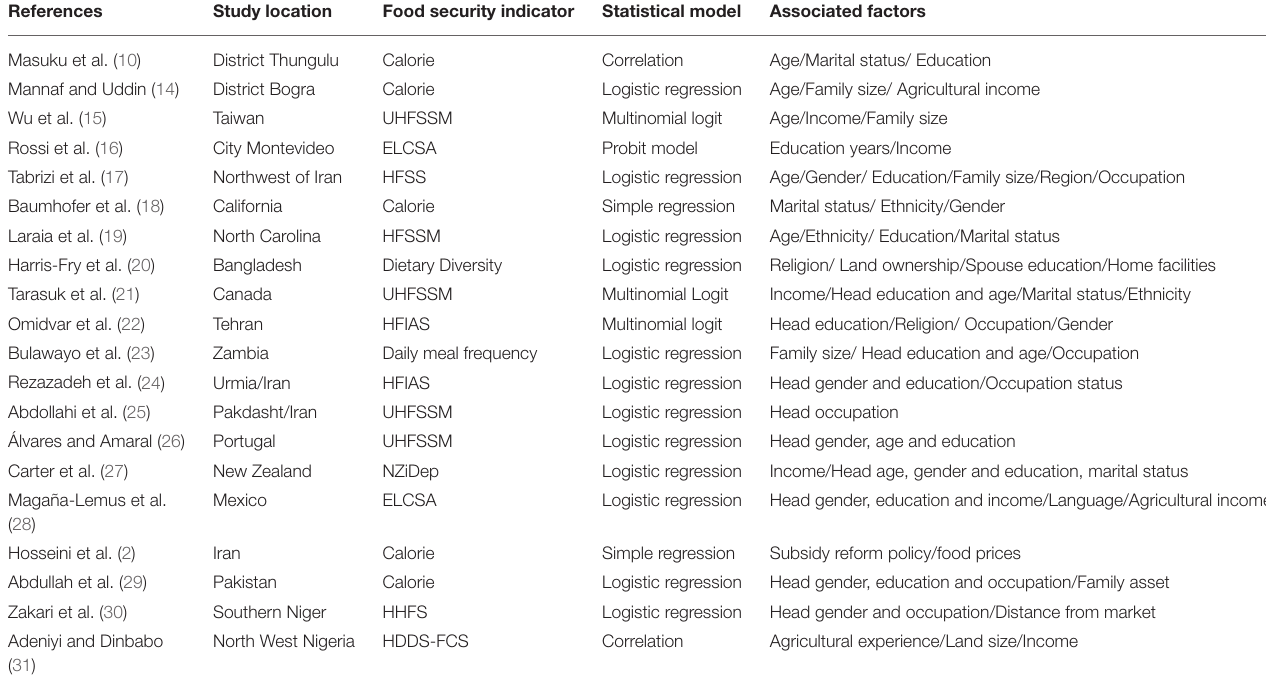
TABLE 1 | Literature review in the field of determining factors associated with food